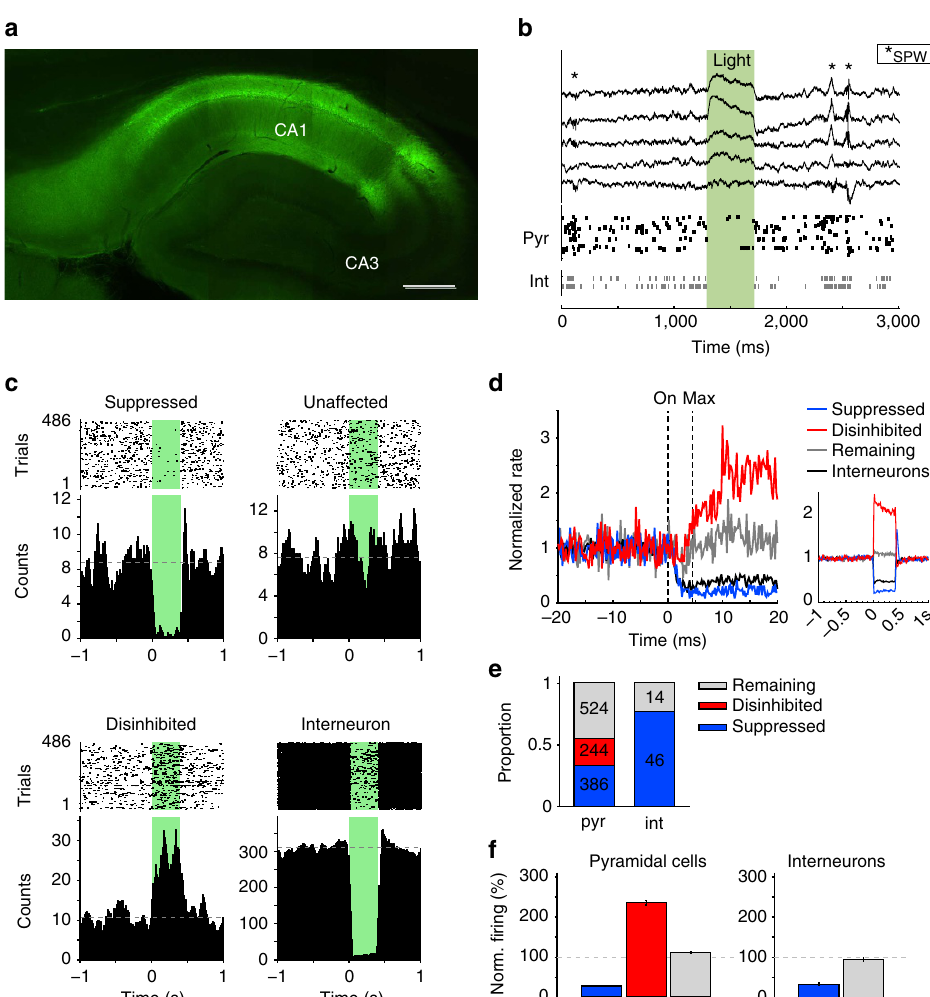
Figure 1 | Optogenetic manipulation of single-unit activity in dorsal CA1 during sleep/rest. ( a ) NpHR-YFP expression in the dorsal CA1 area of a virus-injected rat. Sagittal section; scale bar, 400 m m. ( b ) Brain activity in dorsal CA1 during slow-wave sleep with NpHR activation. Top: wide-band signal from individual channels from five different tetrodes. Asterisks mark sharp wave/ripples (SPW). Bottom: Raster plot showing activity of pyramidal cells (Pyr) and interneurons (Int). Green area marks 400ms laser pulse. Laser pulses were applied at 0.5Hz frequency intervals. ( c ) Raster plots and peristimulus histograms showing light responses of representative suppressed (top left), unaffected (top right) and disinhibited (bottom left) pyramidal groups and a suppressed interneuron (bottom right). Dashed line: baseline firing activity. ( d ) Time course of light responses (left): firing rate 20ms before and after onset of laser pulse. Dashed lines: on, laser onset; max, maximal inhibition of pyramidal cells and interneurons. Right: response to the entire 400-ms laser pulse. ( e ) Proportions of suppressed, disinhibited and remaining cells during rest. Numbers indicate cell counts. Total CA1 units, n ¼ 1,154 pyramidal cells, n ¼ 60 interneurons from 18 recording days in 5 animals. ( f ) Light responses for different cell categories relative to baseline. Error bars represent mean þ